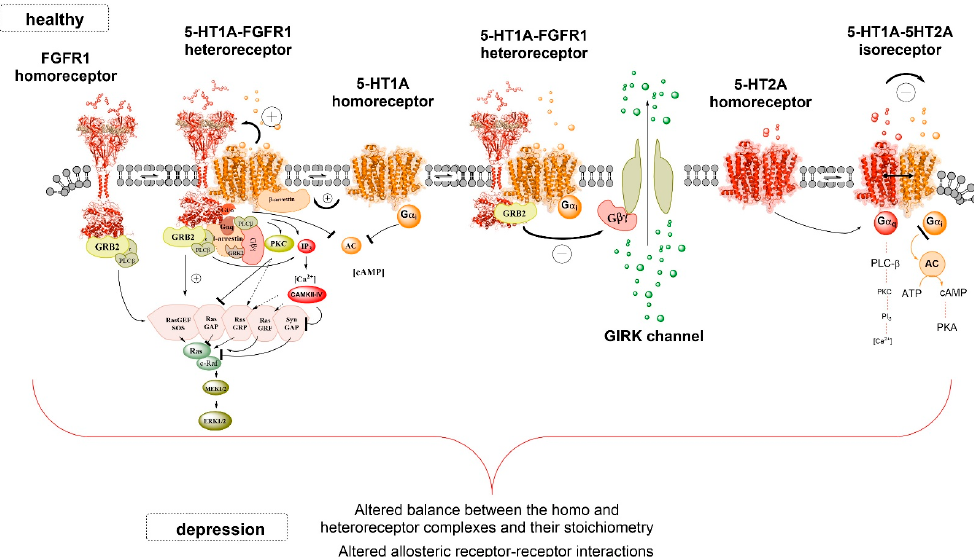
Figure 1. The 5-HT1A-FGFR1 heteroreceptor complexes (to the left) and the 5-HT1A-5-HT2A isoreceptor (to the right) heteroreceptor complexes are illustrated. The term isoreceptor is used for the 5-HT1A-5-HT2A heteromer since the two types of 5-HT receptors are activated by the same transmitter (5-HT). They are in the plasma membrane of control rats (healthy). They are shown to be in balance with the corresponding homoreceptor complexes in the plasma membrane. The FGFR1 homoreceptor complex is presented as a dimer and this is also true also for the 5-HT1A and 5-HT2A homoreceptor complexes. The FGFR1 homoreceptor and the FGFR1 protomer in the heteroreceptor couple are all coupled to ERK1/2, a major signaling pathway for plasticity, via growth factor receptor-bound protein 2 (adaptor protein) and RAS protein. With a curved arrow and plus sign close to it, the allosteric enhancement by the 5-HT1A protomer of the FGFR1 protomer signaling over the GRB2-RAS-ERK1/2 signaling pathway is illustrated. The 5-HT1A receptor protomer is presented as a dimer. As a result, the FGFR1 activation by an FGFR1 agonist is increased, leading to enhanced neuroplasticity involving the ERC1/2 pathway [16]. The 5-HT1A protomer in the heteroreceptor complex mainly signals via Gi/o to inhibit AC activity, like the 5-HT1A homoreceptor, as indicated. The other 5-HT1A-FGFR1 heteromer instead is used to illustrate how the FGFR1 protomer linked to GRB2 upon activation can reduce the coupling of the 5-HT1A protomer to the GIRK channel via an inhibitory allosteric interaction in the heterocomplex. The detailed molecular mechanism is unknown, but the result is an allosteric brake of the 5-HT1AR-induced opening of the GIRK channels. In the dorsal raphe, it leads to an inability of the 5-HT1A auto-receptor to hyperpolarize the dorsal raphe neurons and an increased firing of the dorsal raphe serotonin neurons can develop, leading to antidepressant actions. In the right part of the figure, the 5-HT1A-5-HT2A heteromer is shown as a heterodimer. It is illustrated that the 5-HT2A protomer via an inhibitory allosteric receptor–receptor interaction can reduce its signaling over the Gi/o-AC-PKA pathway. This leads to a dominance of 5-HT2A signaling with depressive effects [20]. The figure especially illustrates how allosteric inhibitory or facilitatory allosteric receptor–receptor interactions among the receptor protomer of the complex can produce antidepressant or depressive events which can help determine if antidepressant or depressive effects